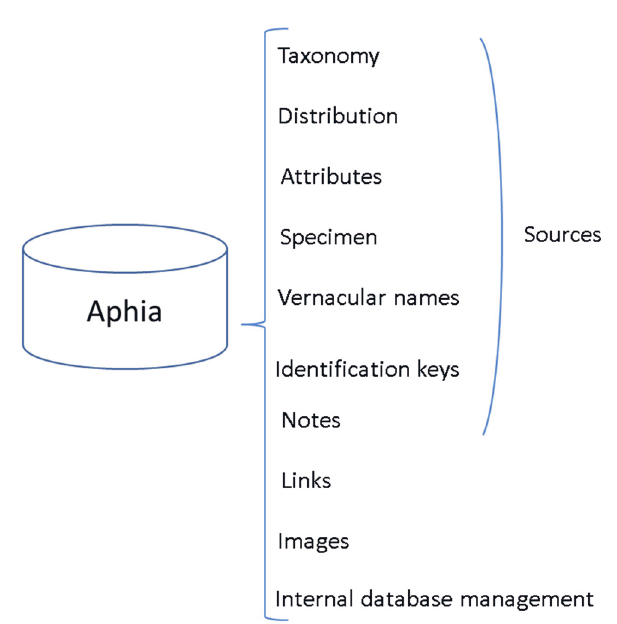
Figure 1. Conceptual representation of the modules in the Aphia database. The sources module is an overarching module: each piece of information added to Aphia—with the exception of links and images—needs to be linked to a